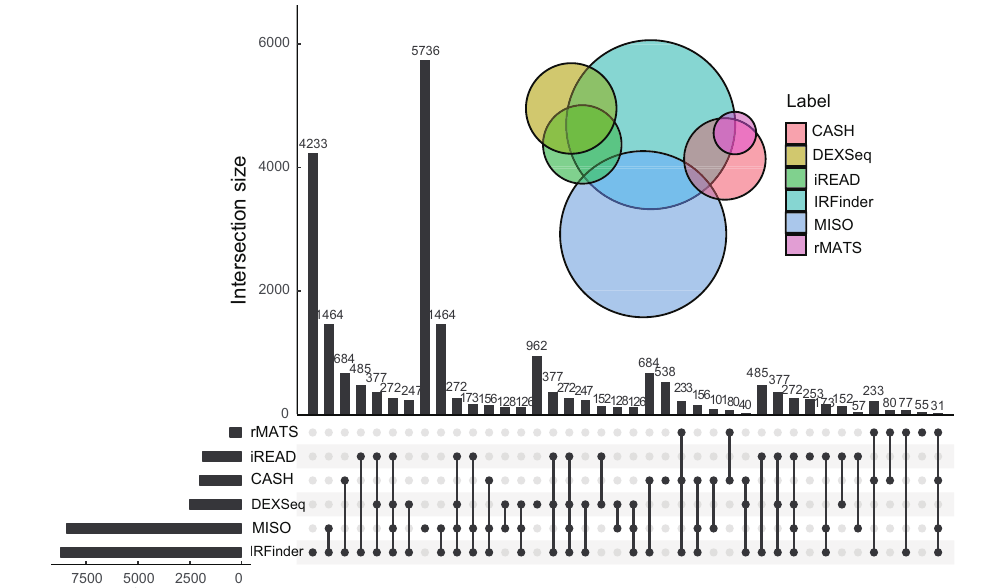
Fig. 1 Venn and UpSet diagram showing the IR intersection of six methods on SIMU30. The Venn diagram is in the upper right corner. The color of the circle indicates the method and the size indicates the number of IRs the method predicts. The UpSet diagram is a combined bar chart at the bottom. The horizontal bar chart on the left shows the total number of IRs predicted by each method. The connection point graph and the vertical bar chart together show the IR intersection between methods. A single point in the connection point graph represents the number of unique IRs predicted by each